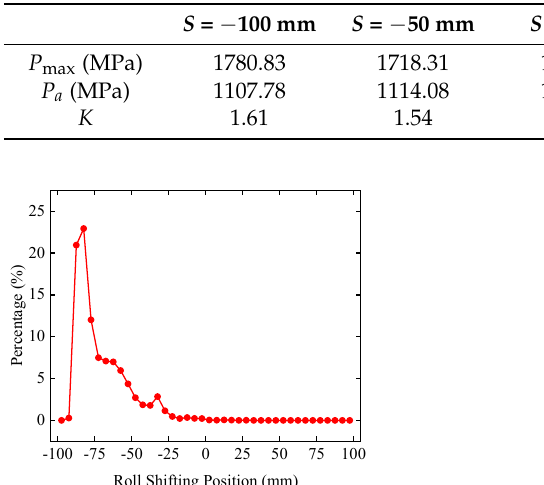
Figure 7. Contact pressure between the rolls at different roll shifting positions S ( B = 1200 mm, q = 12.5 kN/mm).